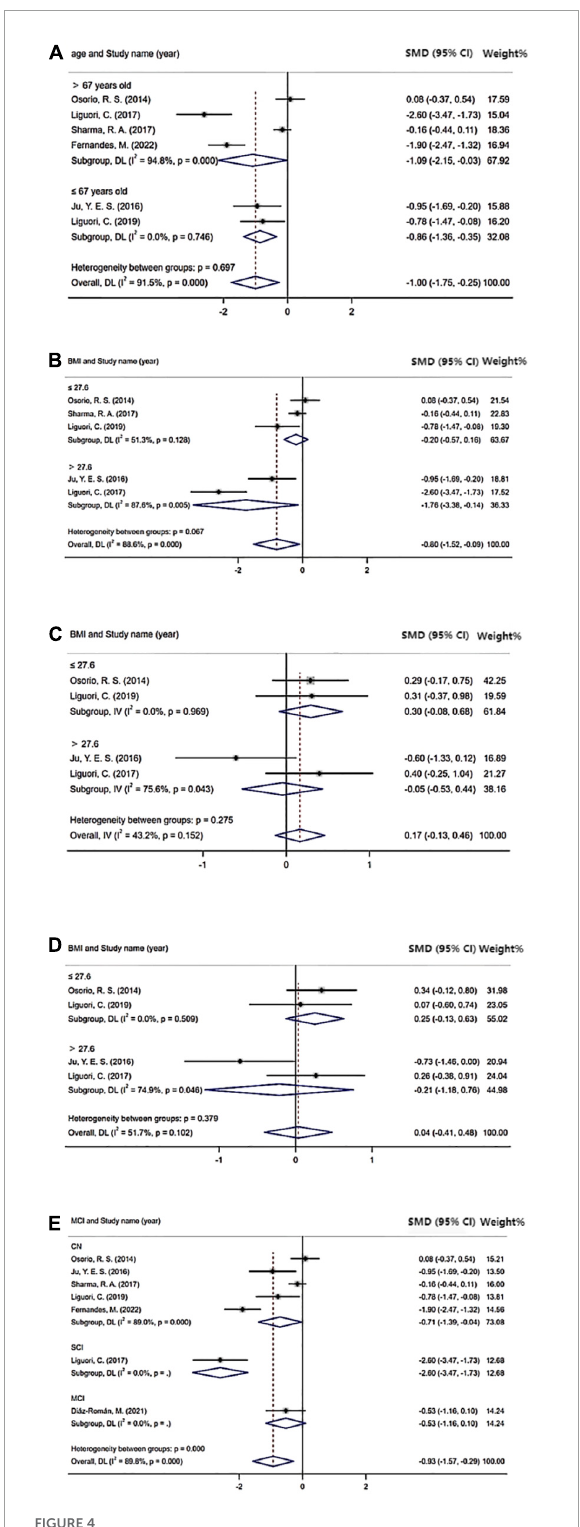
FIGURE4 Sub-group analysis: (A) Cerebrospinal fluid (CSF) A β 42 level based on age; (B) CSF A β 42 level based on BMI; (C) CSF t-tau level based on BMI; (D) CSF p-tau level based on BMI; and (E) CSF A β 42 level based on cognition